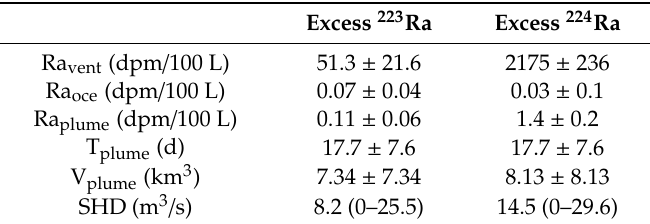
Table 2. The parameterization and results for Ra isotopes used in the submarine hydrothermal discharge (SHD) calculation, Equation (3). The uncertainties assigned to each parameter are discussed in Section 4.2. The SHD flux range according to the propagated uncertainty is given in parentheses. The average residence time of the plume, T plume , was calculated using the hot hydrothermal end member activity ratio from Neuholz et al. [39] and sample ex 223 Ra and ex 224 Ra activity ratios. Table 3. Comparison of calculated plume ellipsoids dimensions and volumes based on excess 224 Ra and excess 223 Ra activity above background levels. The volume is corrected for any overlap of the plume ellipsoid with local topography (i.e., caldera rim).